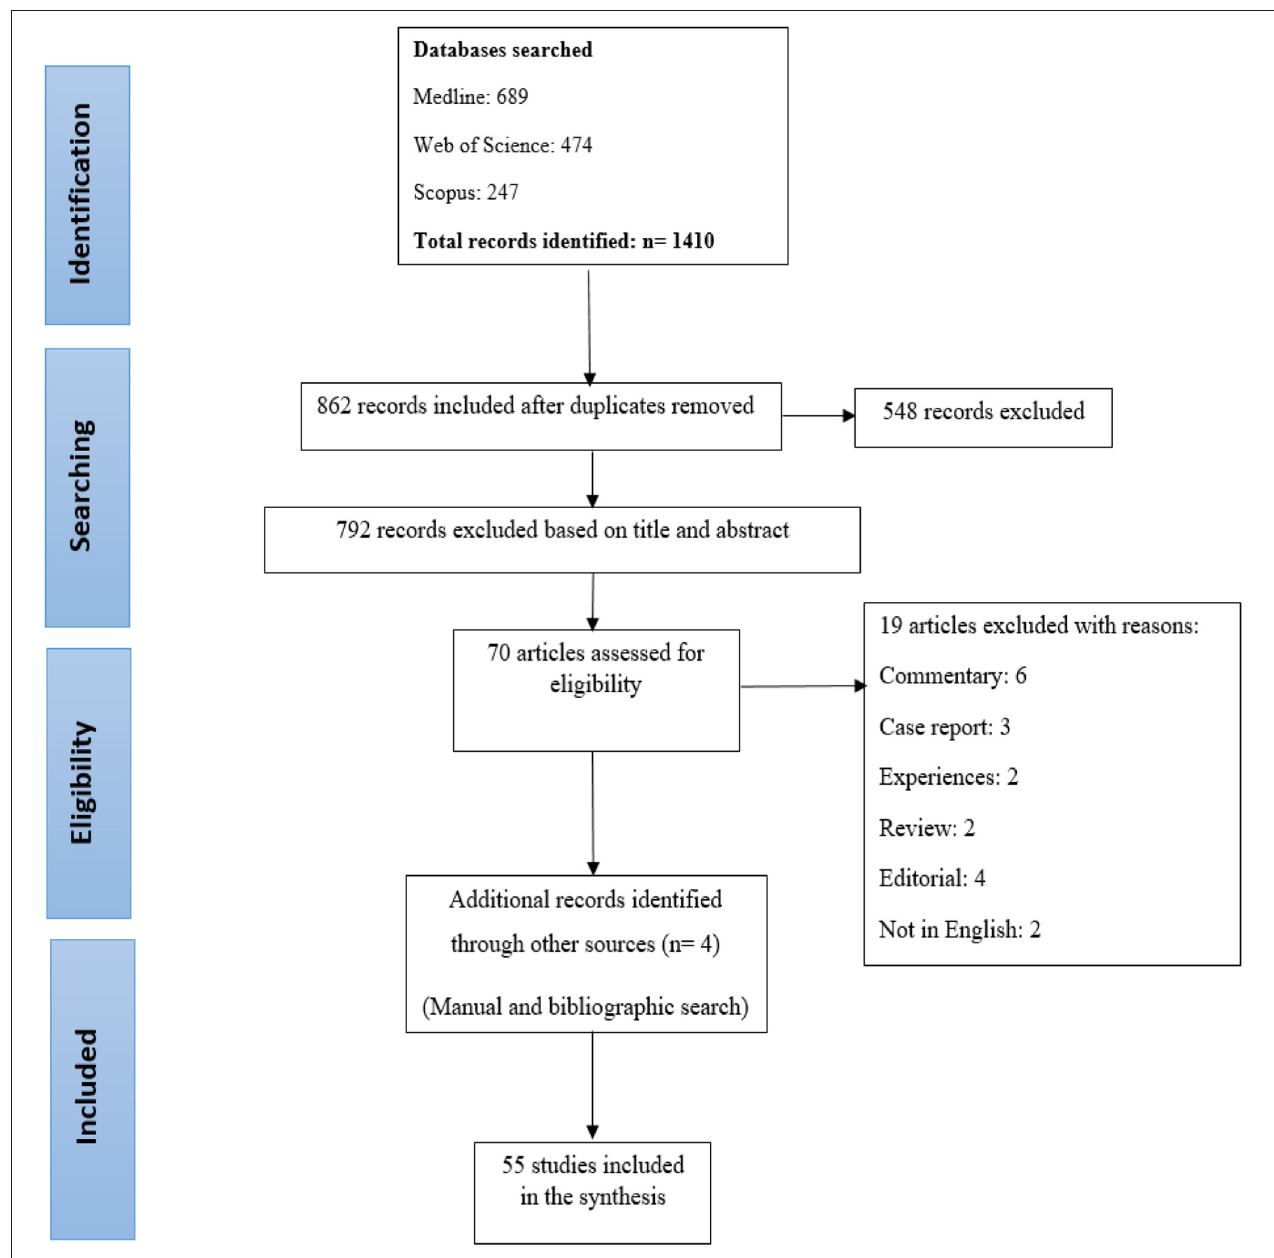
FIGURE 1 | Study flow